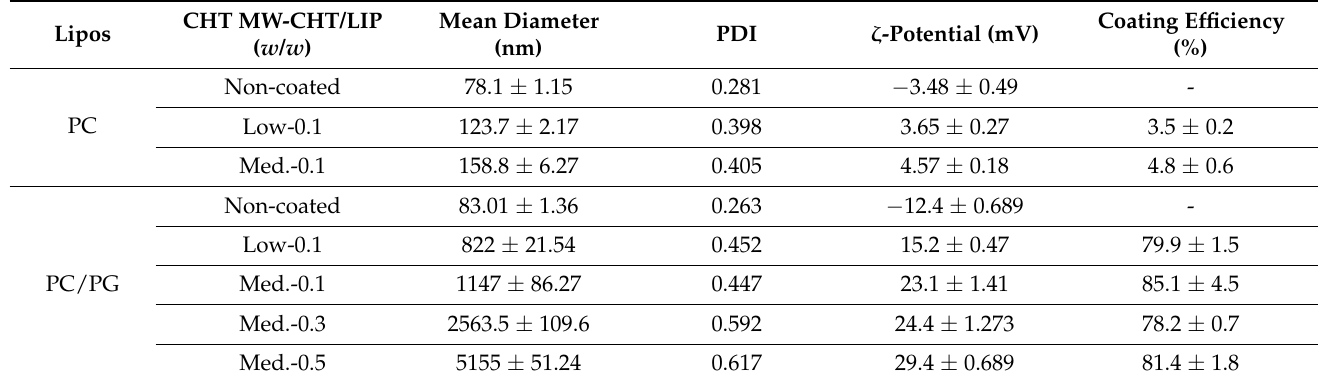
Table 1. Physicochemical properties of the CHT-coated LIPs. Effect of lipid membrane composition and CHT type and amount.